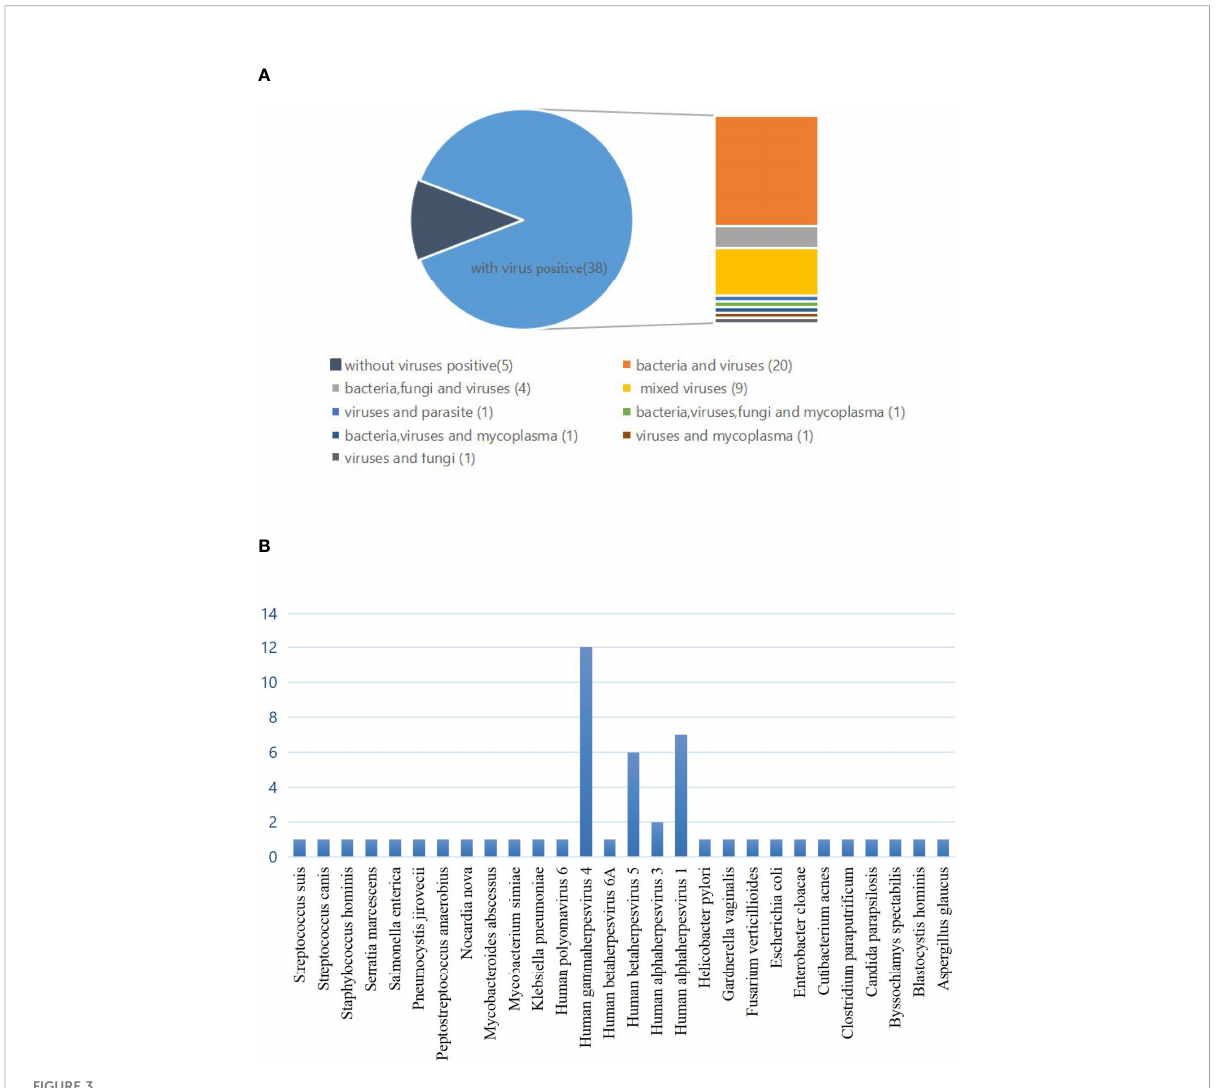
FIGURE 3 (A) The classi fi cation of mixed infections with or without viruses detected by mNGS and conventional diagnostic testing methods (CDT). In the mixed infection, there were 5 cases with no virus infection and 38 cases with virus infection, namely, 20 cases of bacteria and viruses infection; 4 cases of bacteria, fungi, and virus infection; 9 cases of virus mixed infection; 1 case of bacteria, virus, fungi, and mycoplasma infection; 1 case of bacteria, virus, and mycoplasma infection; 1 case of virus and mycoplasma infection, and 1 case of virus and fungi infection. (B) Distribution of pathogens for single